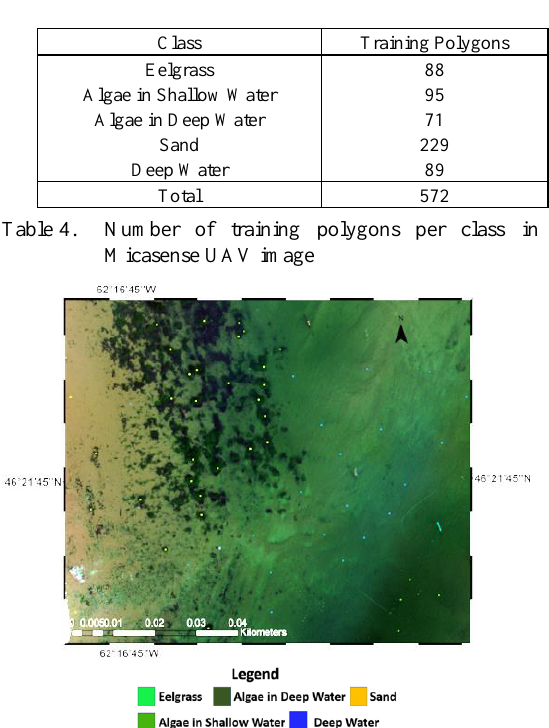
Figure 6. Sample of training areas used in the UAV Micasense image classification